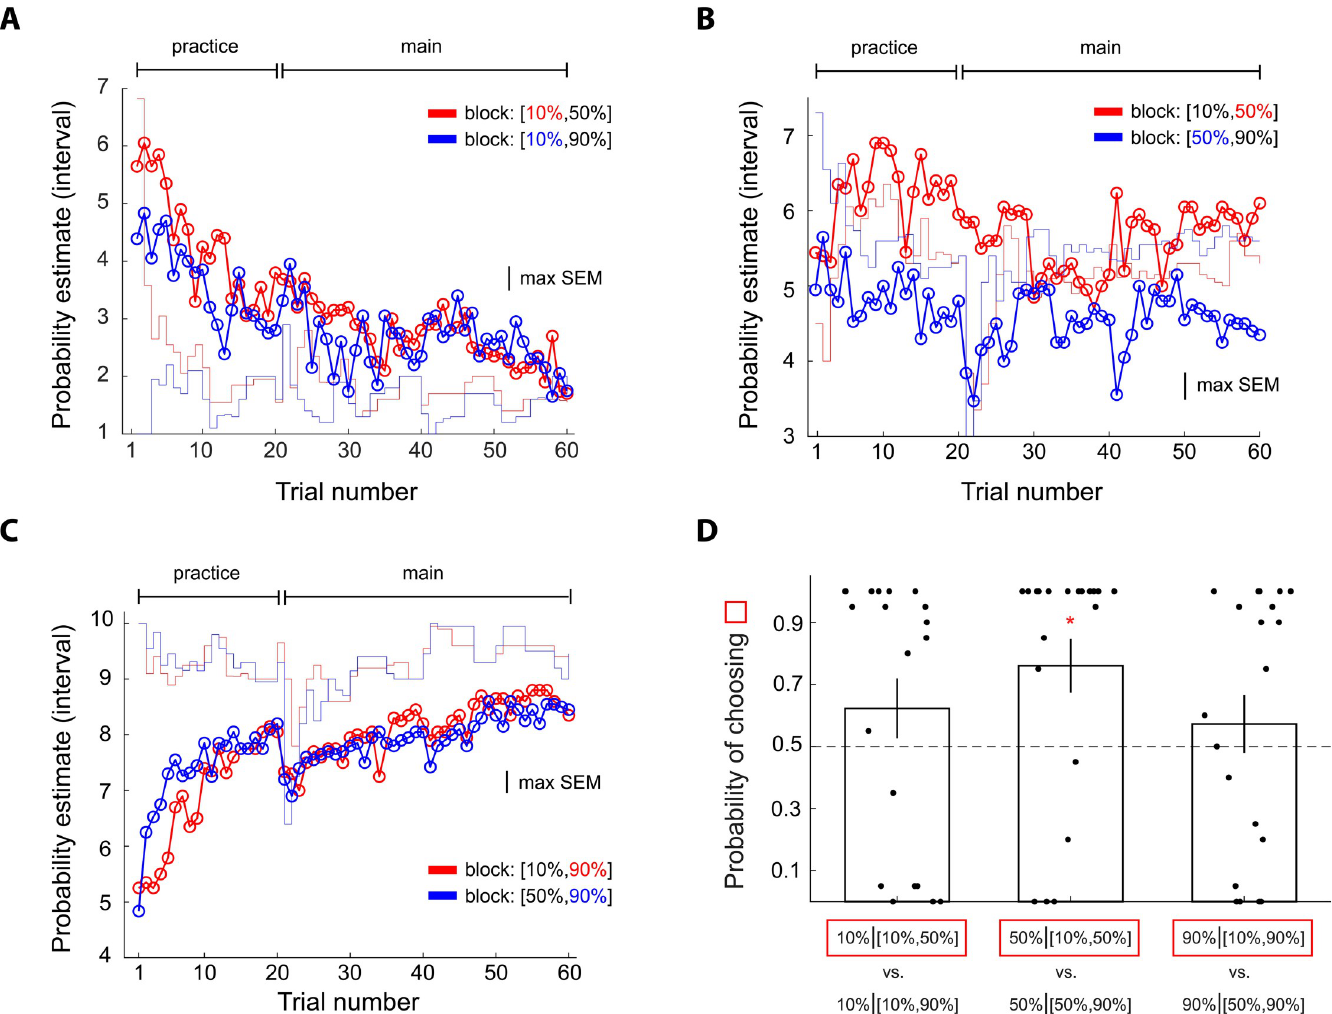
Fig 5. A behavioral control experiment (Experiment 2) examining whether context effect and lack thereof on probability estimates found in Experiment 1 was because of the design of the interval-to-button mapping. Conventions are the same as in Figs 3 and 4. The design of the experiment was identical to Experiment 1 except that there were 10—as opposed to 8—key buttons, each representing a unique interval of probability [0, 1] for the subjects to indicate probability estimates. (A) Probability estimates of the 10% reward stimuli. (B) Probability estimates of the 50% reward stimuli. (C) Probability estimates of the 90% reward stimuli. The scale on the vertical axis indicates interval estimate (from 1 to 10 with 1 representing the smallest probability interval [0%–10%] and 10 representing the largest probability interval [90%–100%]). (D) Choice probability in the lottery decision task following the probability estimation task. Error bars represent ± 1 SEM. The red star symbol indicates significant difference in choice probability from 0.5 based on 95% bootstrap confidence interval. Data underlying these graphs can be found in https://osf.io/